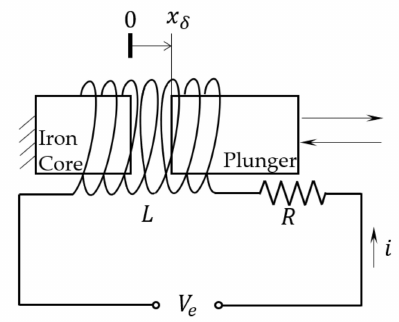
Figure 2. Diagram of valve’s driving coil.